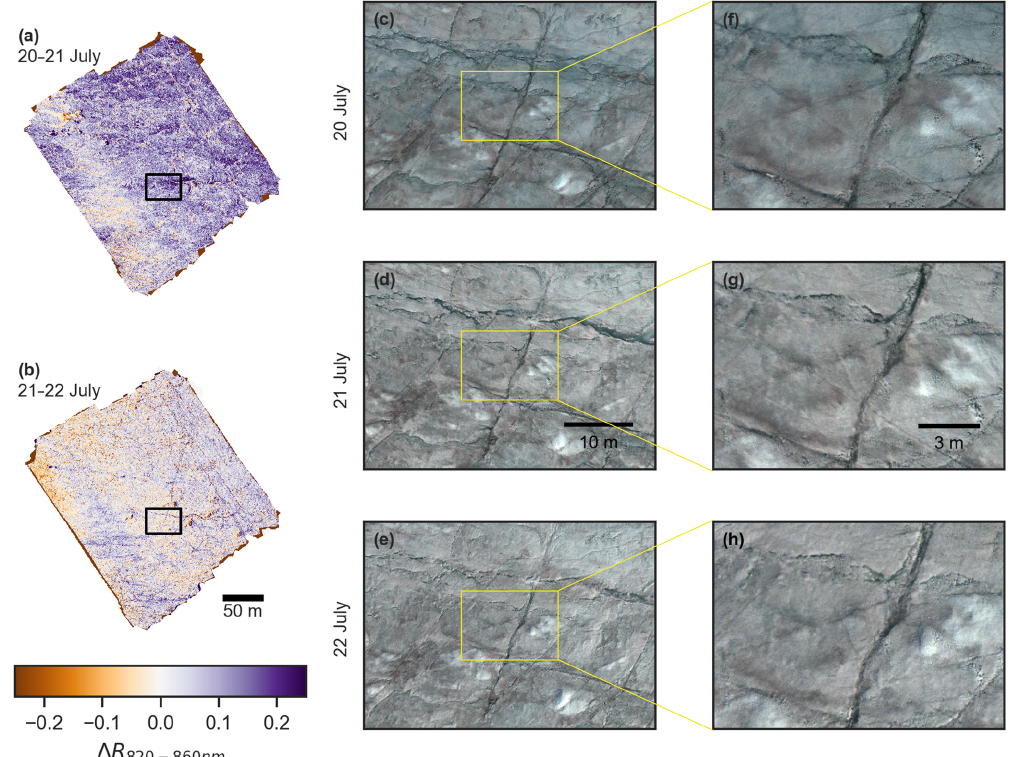
Figure 4. Weathering crust evolution. (a) Change in 840nm reflectance between 20 and 21 July 2017: positive values indicate an increase in reflectance from 20 to 21 July. (b) as in (a) but for 21–22 July change. (c–e) RGB true-colour composites of surface within black rectangle shown in panels (a) and (b) . (f–h) Zoomed RGB true-colour composites of surface within yellow rectangle in panels (c) – (e) . (c,